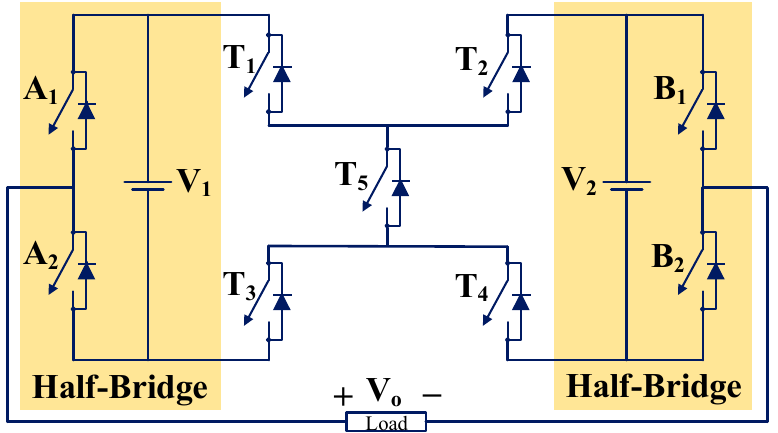
Figure 12. Single-phase five-level DITHB inverter with fault tolerance capability (TP12) [37].